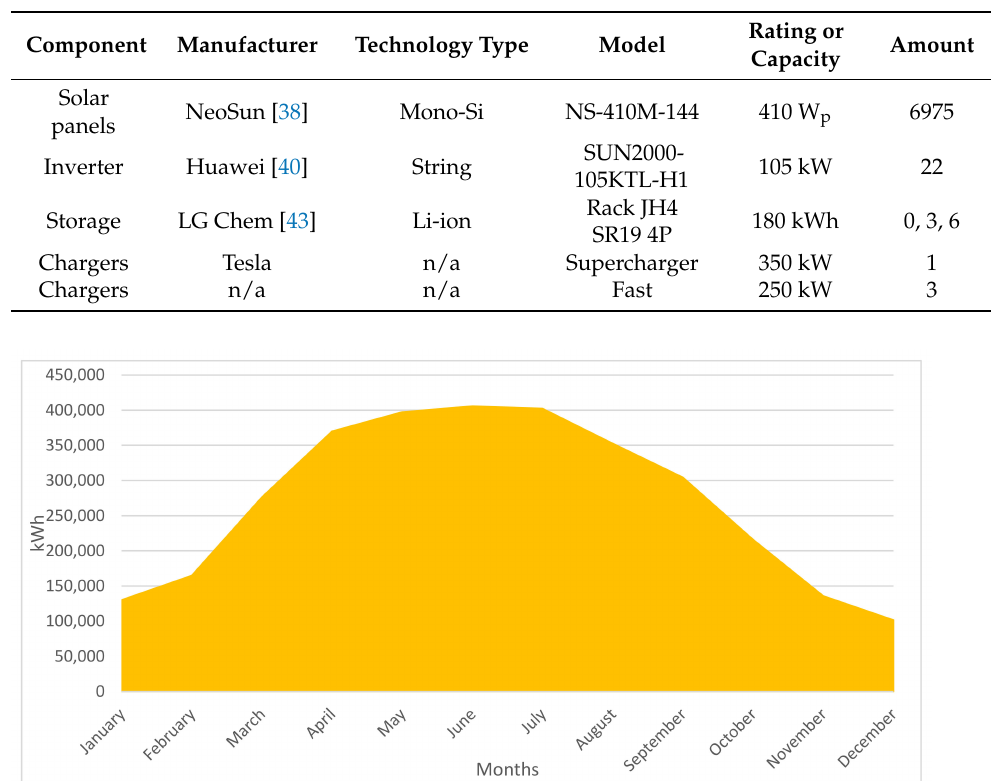
Table 3. A summary table of the components selected for the PVEVCS.